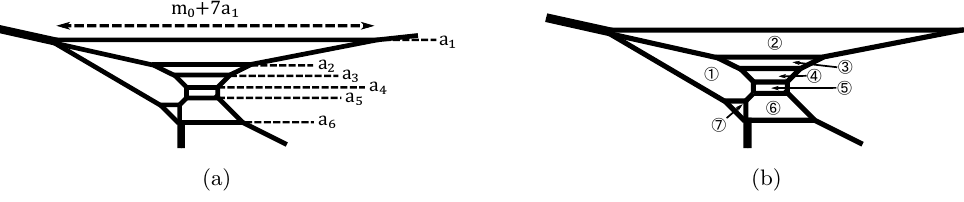
Figure 5 . (a) A parameterization of Coulomb branch moduli for the diagram in (cid:12)gure 3. (b) A labeling for the area of faces in the diagram in (cid:12)gure 3. As the external 5-branes are bound by 7-branes such that they satisfy the S-rule, some of the faces are in fact connected. For instance, 1